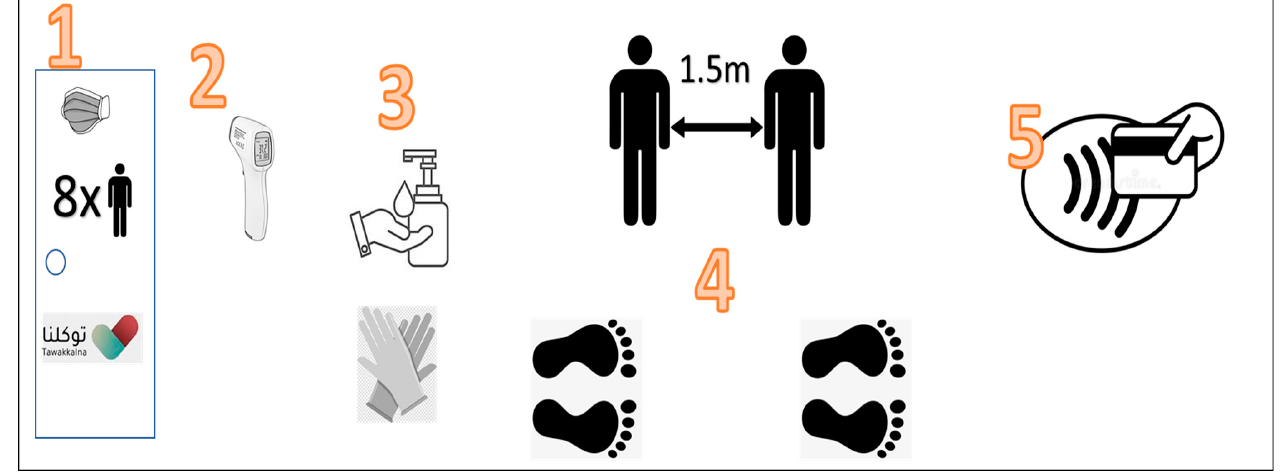
Figure 5. The current protective measures taken in closed spaces in Saudi Arabia. (1) The entry requirements to each place, which include stating the maximum number of people at one time, wearing a face mask, and having an active Tawakkalna application. (2) The mandatory temperature check upon entry through contactless means. (3) The provision of hand sanitizers and, if needed, disposable gloves like those available in supermarkets. (4) The strict social distancing rules of at least 1.5 m between building occupants are usually shown as floor markings. (5) The provision of contactless payment options at all vending points.